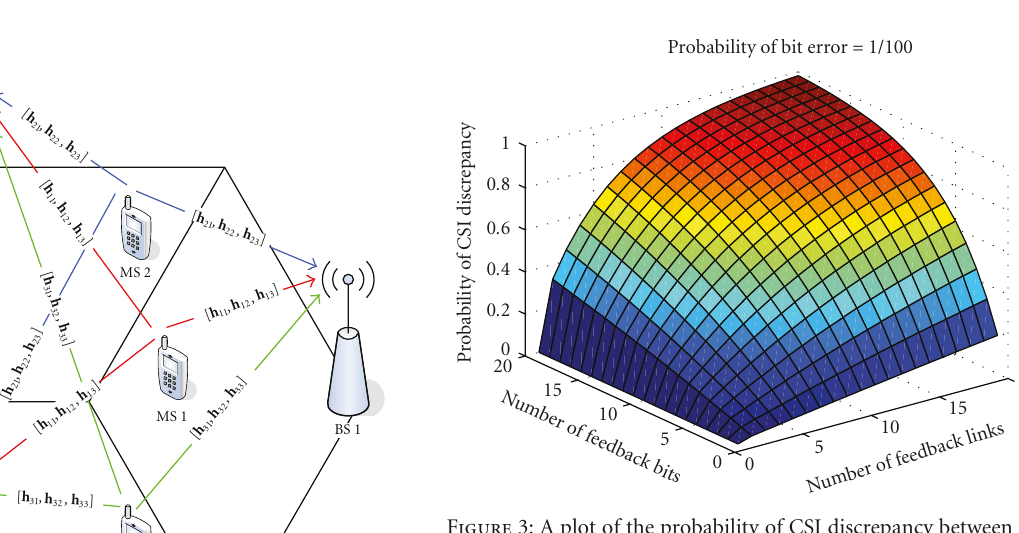
Figure 3: A plot of the probability of CSI discrepancy between the collaborating BSs P d in the decentralised framework as a function of the number of independent feedback links (equal to the number of involved BSs) and the number of feedback bits (18). The assumed bit error probability is P e = 10 − 3